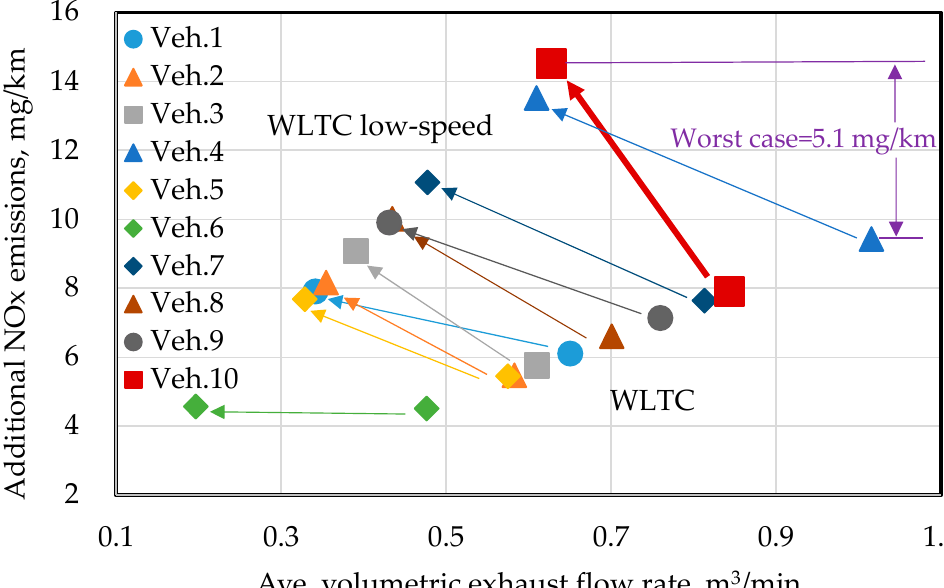
Figure 5. Determination of the worst case of NOx zero drift.